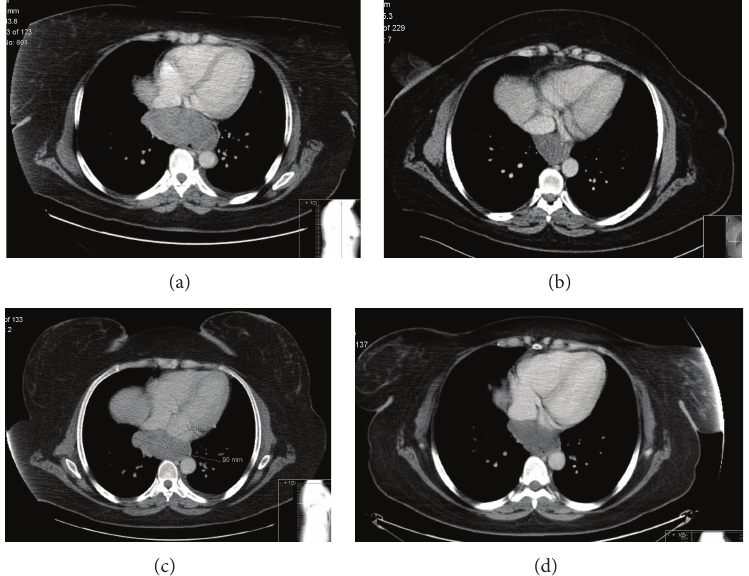
Figure 2: (a) CT scan at diagnosis, Longest Axial Diameter (LAD) 99 mm; (b) CT scan after 10 months of imatinib therapy, partial response LAD 54 mm; (c) CT scan after 13 months of imatinib therapy, disease progression LAD 90mm; and (d) CT scan after 26 months of imatinib therapy, partial response LAD 44